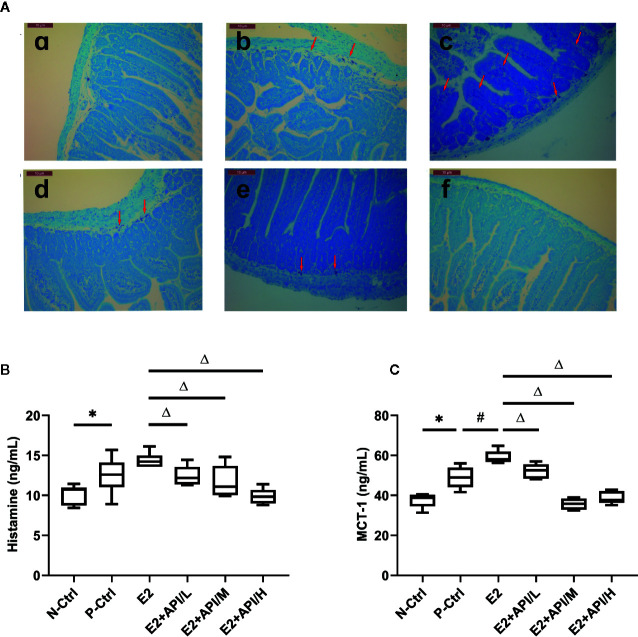
The degranulation of mast cells was attenuated by administration of API in vivo. (A) Representative Toluidine blue staining results from small intestine tissue of mice, red arrow points to degranulated mast cells. a: N-Ctrl group; b: P-Ctrl group; c: E2 group (0.15 mg/kg body weight); d–e: E2 + API/L/M/H (75, 150, 300 mg/kg body weight) group. (B) ELISA analysis results for plasma histamine and serum (C) MCT-1. Data are presented as the mean ± SEM from 10 mice. *P < 0.05 as compared to the N-Ctrl group, #P < 0.05 as compared to the P-Ctrl group, △P < 0.05 as compared to the E2 group.